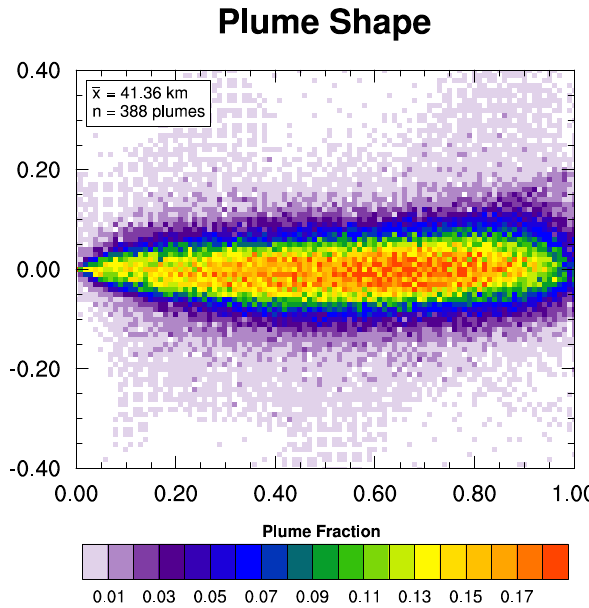
Fig. 5. Plume fraction of the composite plume, plotted in rela- tive coordinates. Values indicate fraction of contributing ( N = 388) plumes that are present at a point.